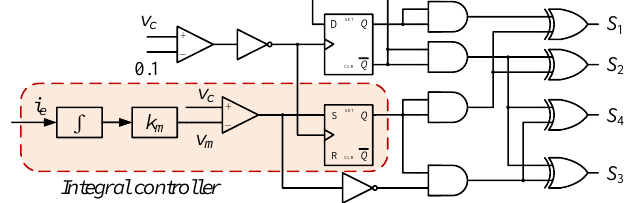
Figure 10. Modulation method of LCLC resonant inverter.